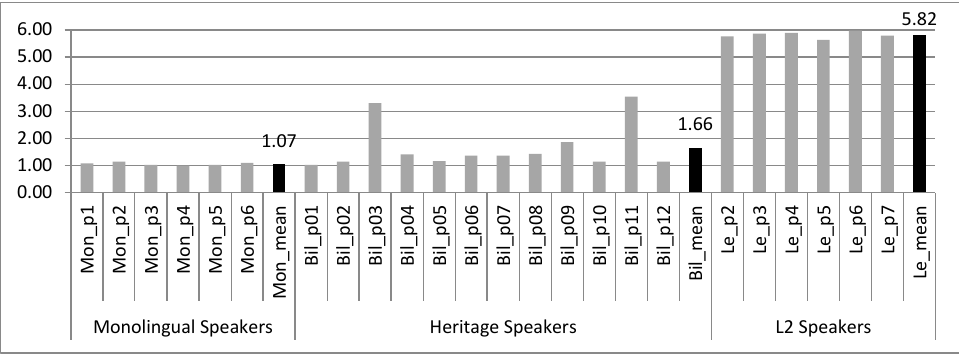
Figure 1. Degree of Nativeness per Group (from (Flores et al. 2017b)).